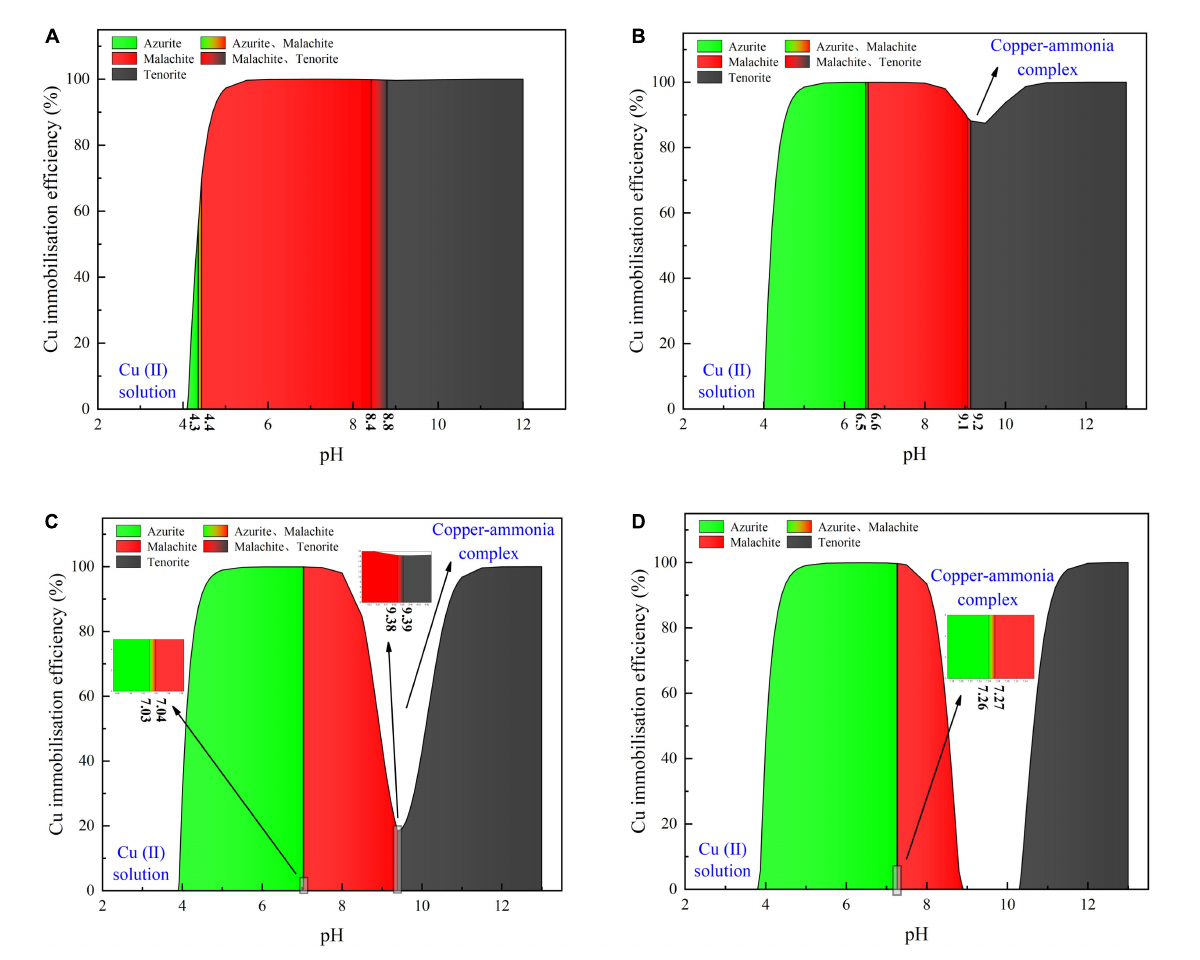
FIGURE6 (A) copper immobilization efficiency vs. pH relationship for the inoculation proportion = 1:9, (B) copper immobilization efficiency vs. pH relationship for the inoculation proportion = 1:3, (C) copper immobilization efficiency vs. pH relationship for the inoculation proportion = 1:1, and (D) copper immobilization efficiency vs. pH relationship for the inoculation proportion = 3:1 [Cu(NO 3 ) 2 concentration = 40